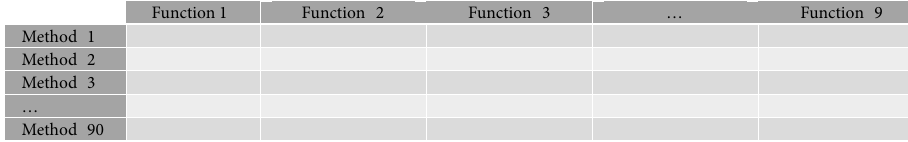
Fig. 3. Scheme of the questionnaire for the assessment of methods with the potential use in